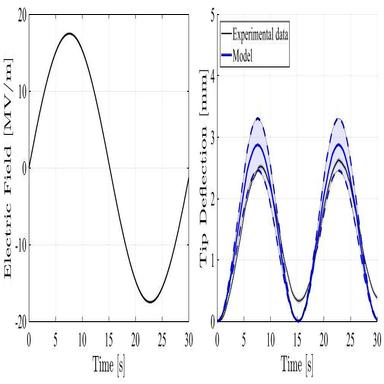
Time transient experimental data and model tip deflection when a sinusoidal electric field input is applied to (at least) three soft actuators with transversally aligned nanofibers integrated in PDMS. The blue shaded areas represent the simulation results with the relative permittivity values spanned between 9 and 12, while the gray shaded areas represent the standard deviation on the electromechanical characterization.